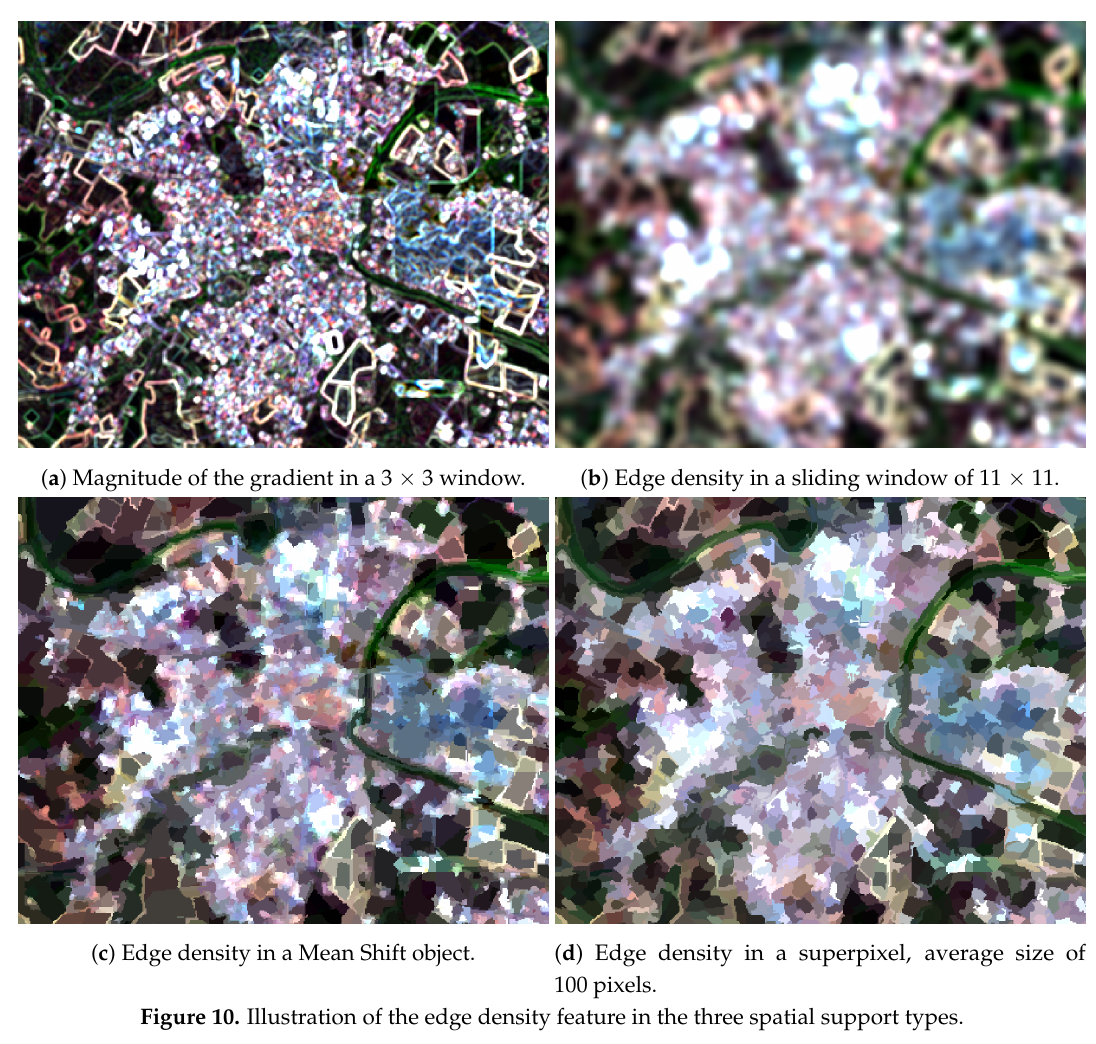
Figure 10. Illustration of the edge density feature in the three spatial support